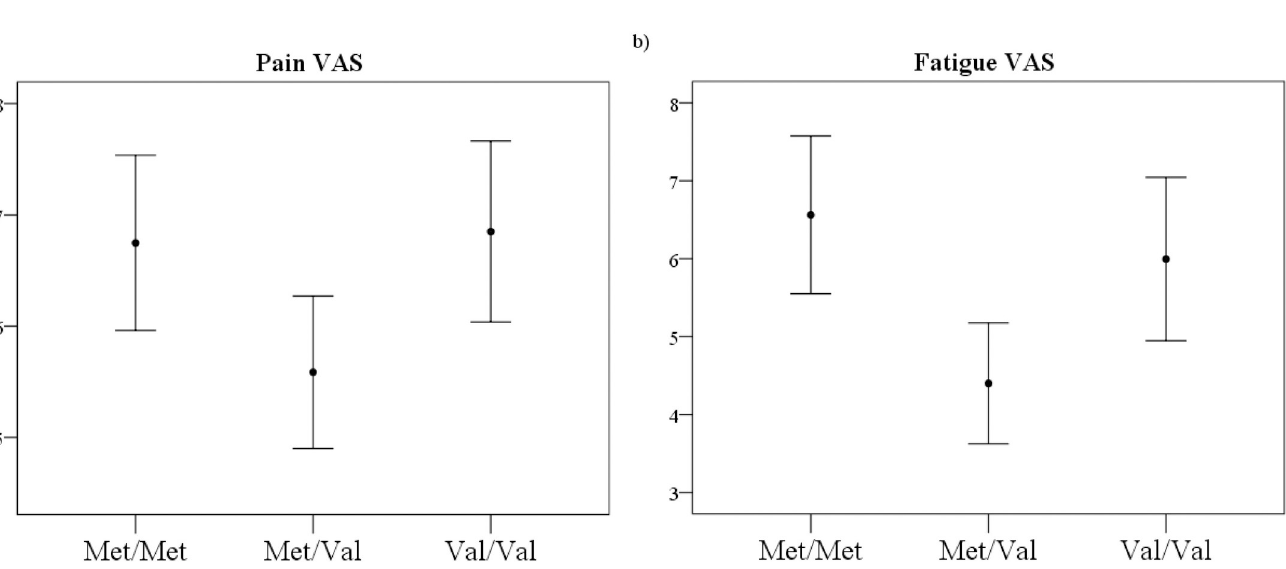
PLOS ONE | https://doi.org/10.1371/journal.pone.0250547 April 28,